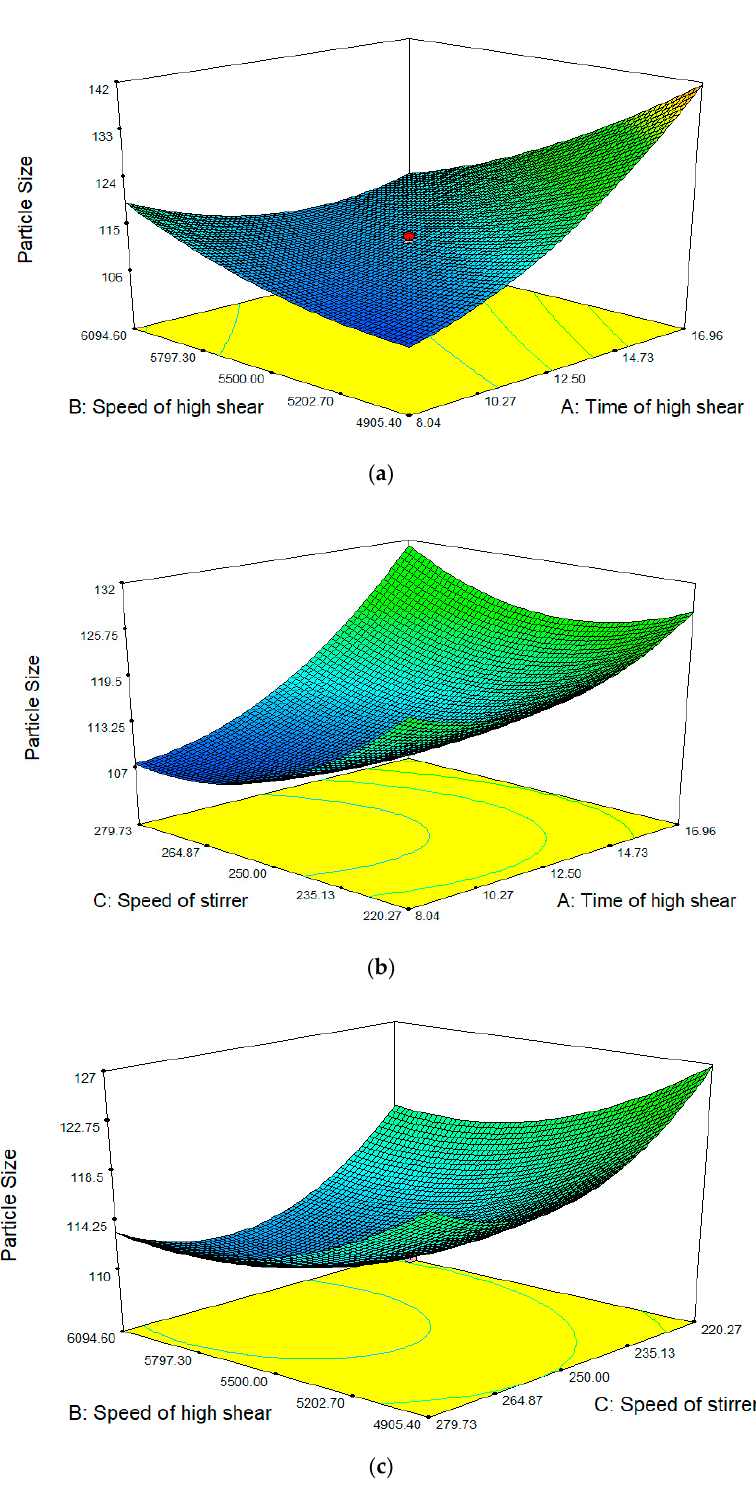
Figure 2. Response surface showing the effect of ( a ) time of high shear and speed of high shear; ( b ) time of high shear and speed of stirrer; ( c ) speed of high shear and speed of stirrer.